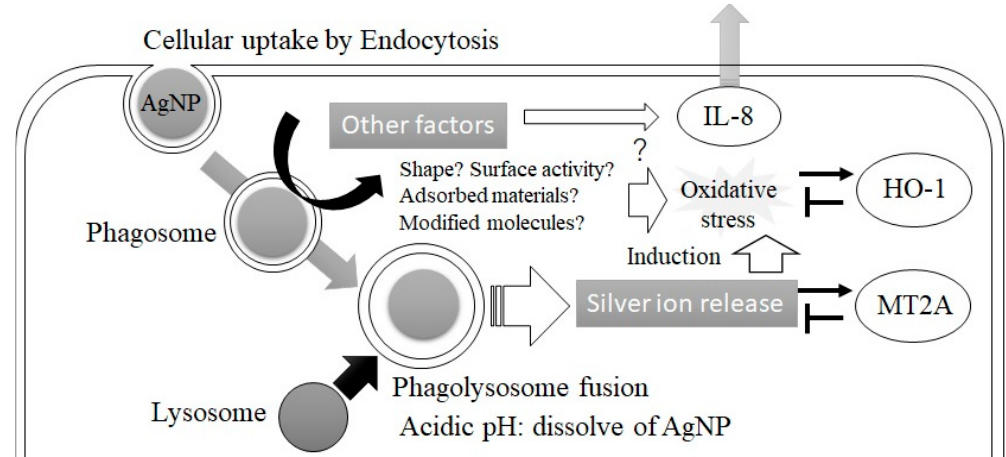
Figure 6. Summary of cellular effects caused by AgNP in this study. In conclusion, AgNPs induced IL-8 and HO-1 expression, but cytotoxicity was weak. Moreover, increased intracellular silver concentrations contributed to the elevation of IL-8 and HO-1 expression. The increase of intracellular Ag 2+ level caused by silver nanoparticle suspensions may be important for these cellular responses.